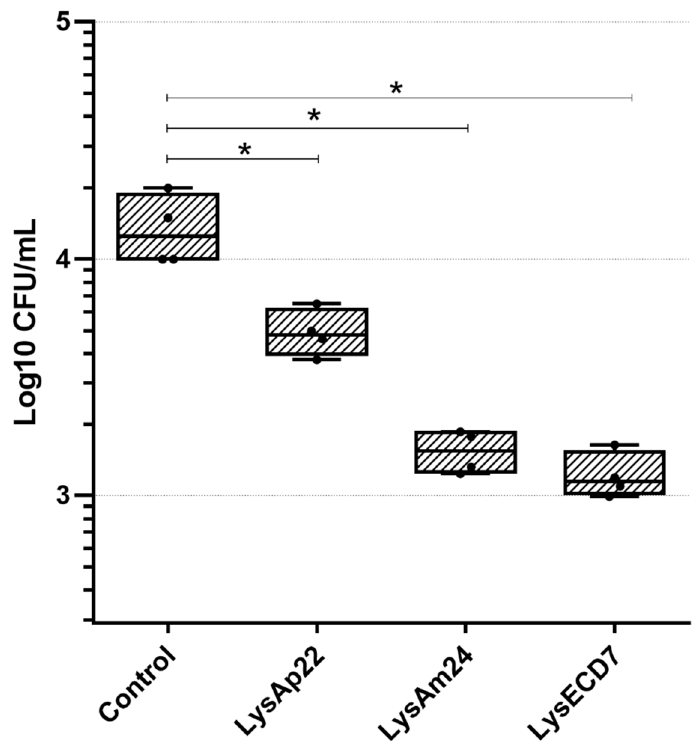
Figure 1. Endolysins activity against F. necrophorum 89-5 at a protein concentration of 100 µ g/mL each. For all experiments, the mean values are shown with SD. An asterisk (*) indicates a significant difference in antimicrobial activity compared with the control with Tris-HCl incubation ( p < 0.05, one-way ANOVA, Dunnett’s multiple comparisons test).